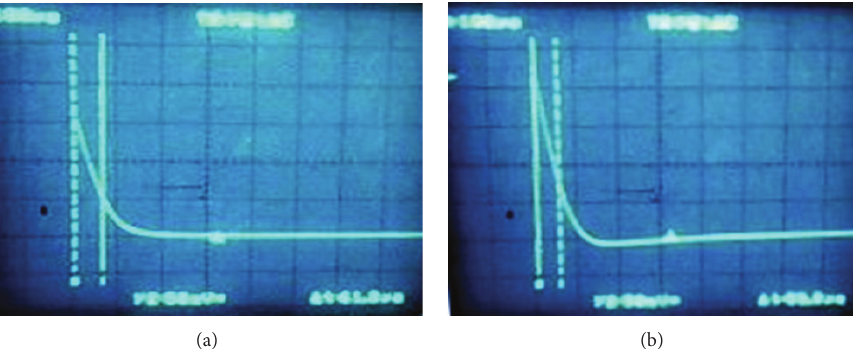
Figure 8: Carrier life time. (a) (n-SnO 2 /n-Si) device, (b) (n-SnO 2 /p-Si) MIS device.